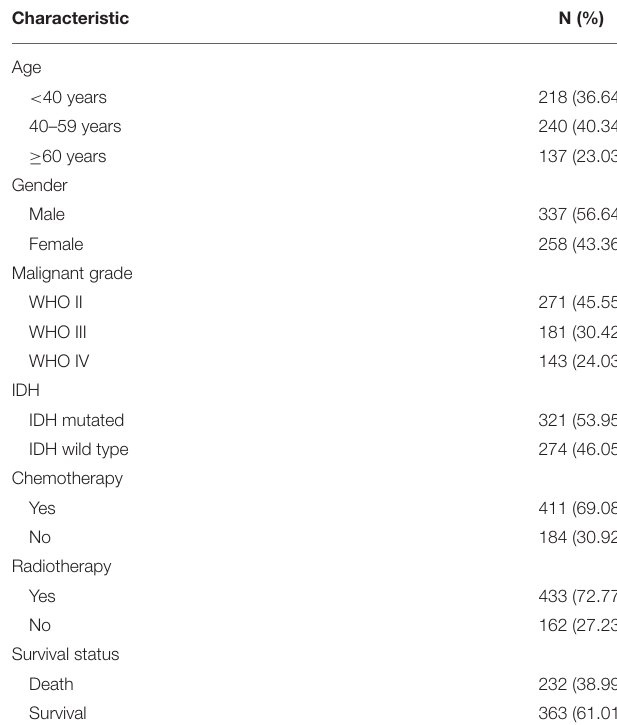
TABLE 1 | Clinical characteristics of the study